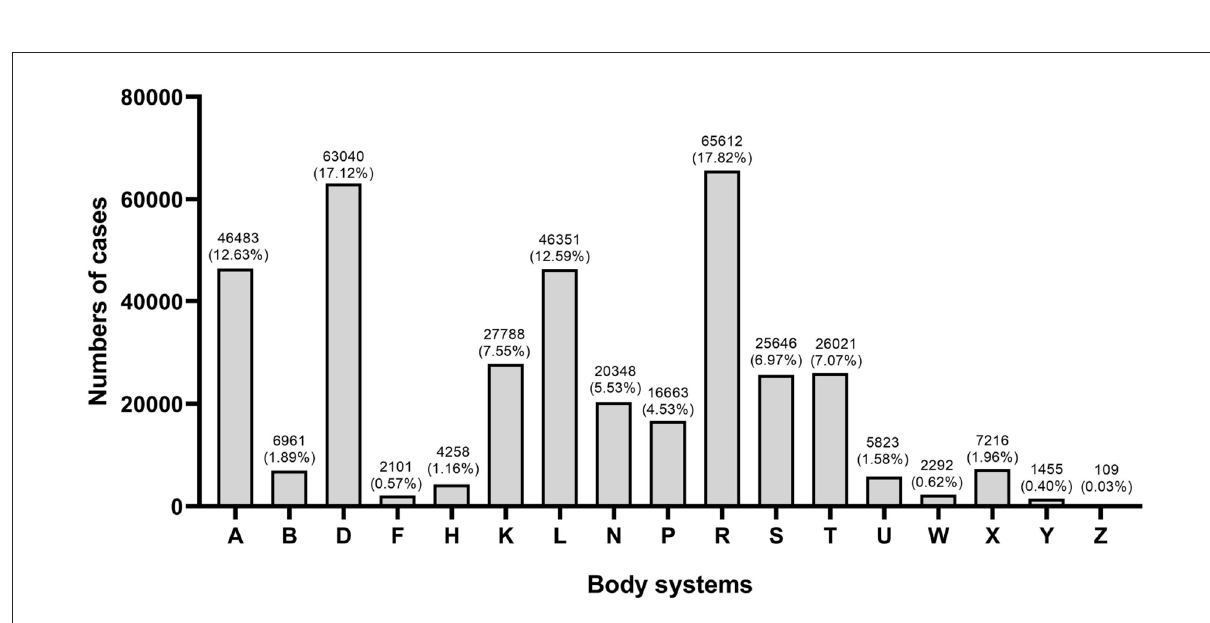
FIGURE1 Distribution of health problems by body